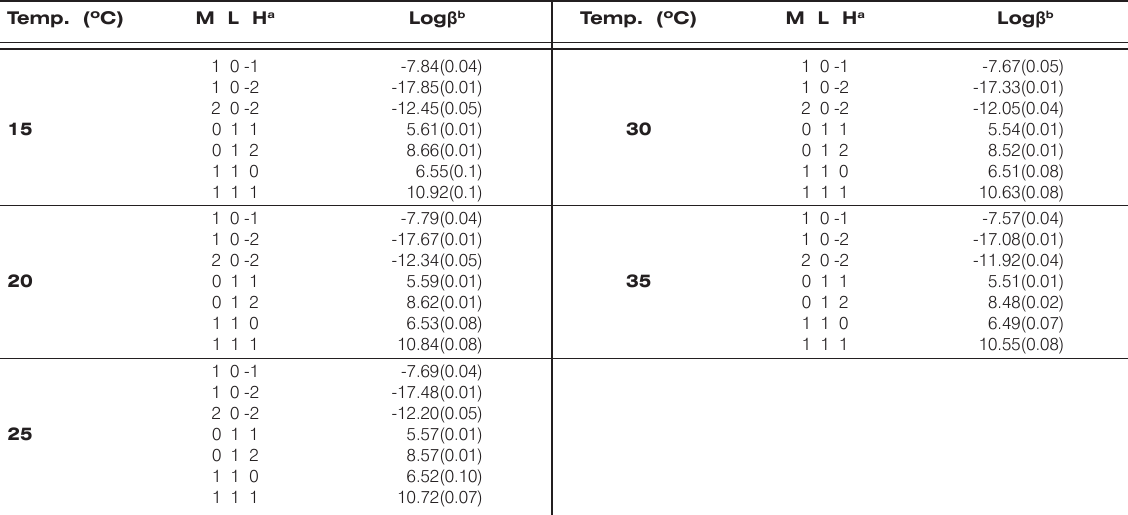
O) ] 2+ with CBDCA at different temperatures and 0.1 M ionic strength. 2 2